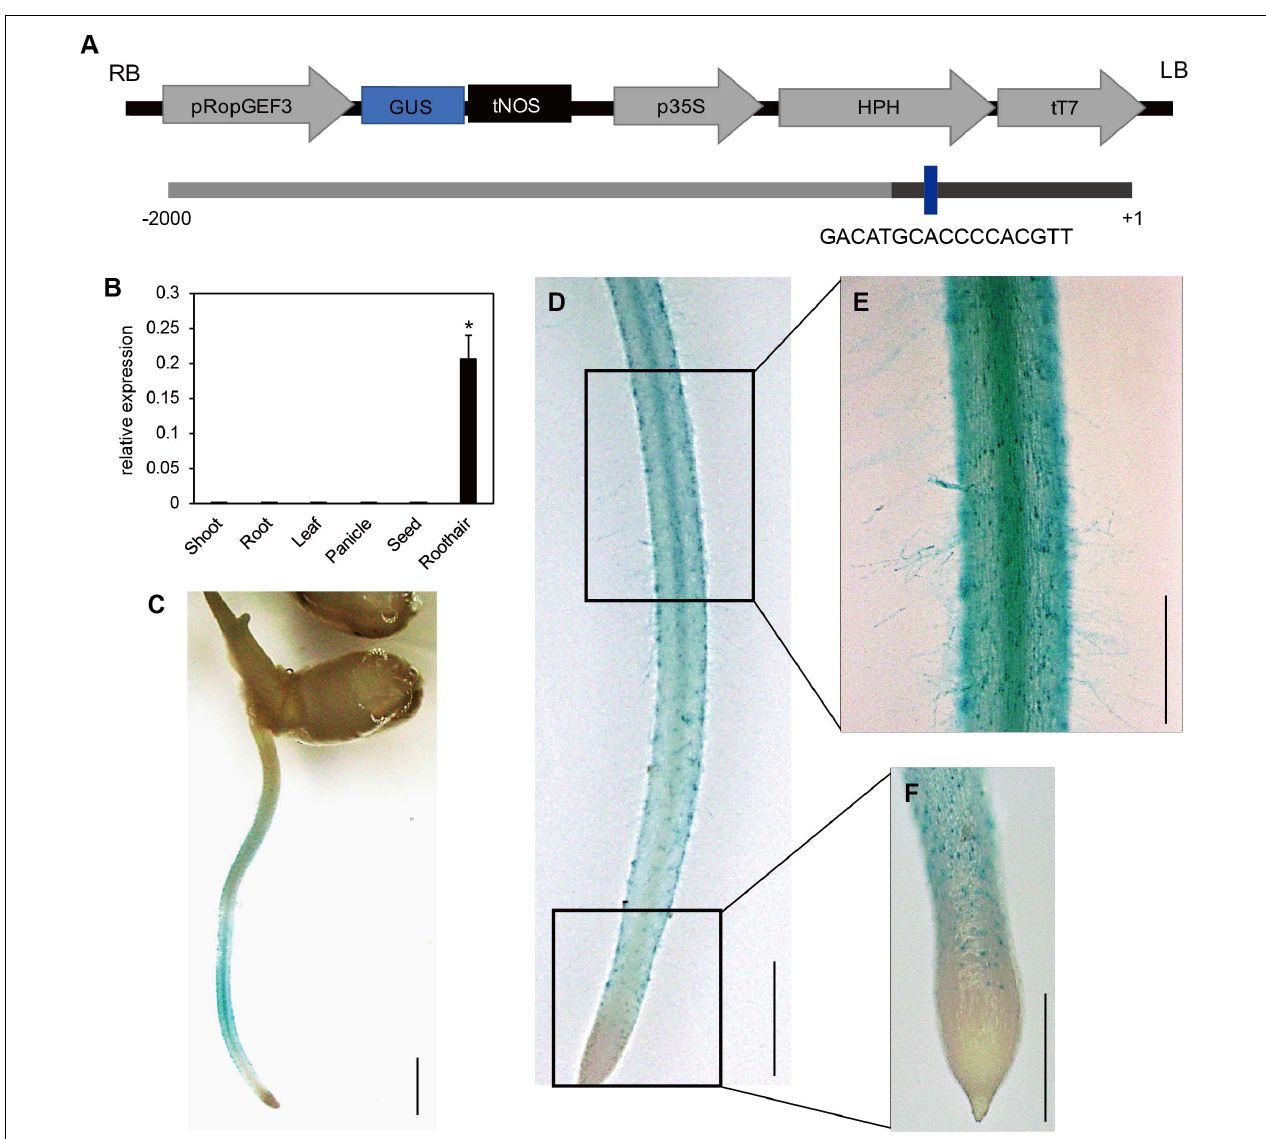
FIGURE 1 | Expression pattern of OsRopGEF3. (A) The pGA3519 vector map used for histochemical GUS assay of OsRopGEF3 genes. The pGA3519 vector contains a sequence of hygromycin-resistance genes. LB, left border of the vector; RB, right border of the vector; pOsRopGEF3, promoter sequence of OsRopGEF3 ; GUS, beta-glucuronidase; tNOS, NOS terminator; p35S, 35S promoter; HPH, Hygromycin-B-phosphotransferase gene; tT7, T7 terminator. The following shows the promoter region of OsRopGEF3. The dark bar represents the 5 (cid:48) -untranslated region (UTR). The RHE cis-element region is present in the promoter of OsRopGEF3. + 1 means the first base of the start codon, and -2,000 means 2,000 base pairs upstream from it. (B) The real-time quantitative PCR (RT-qPCR) analysis of OsRopGEF3 from diverse rice tissues. Rice ubiquitin 5 gene ( OsUBI5 ; LOC_Os01g22490) was used as an internal expression control. X -axis, the sample name used for analysis; Y -axis, the relative expression level of OsRopGEF3. The error bar indicates standard errors in three biological replicates. Significant differences are indicated by asterisks, * p < 0.01. The data were analyzed using one-way ANOVA with repeated measurements using Tukey’s pairwise comparison test. (C–F) Histochemical GUS assay of transgenic lines. The 2,000 base-pair upstream region from the start codon of OsRopGEF3 genes cloned and ligated to the pGA3519 vector. (C) The picture of whole plants, bars = 3 mm. (D) The entire root from the apical tip to the maturation zone, bars = 2 mm. (E) The root hairs and the elongation zone of root, and (F) the apical tip and meristematic zone of the root, bars = 500 µ m.